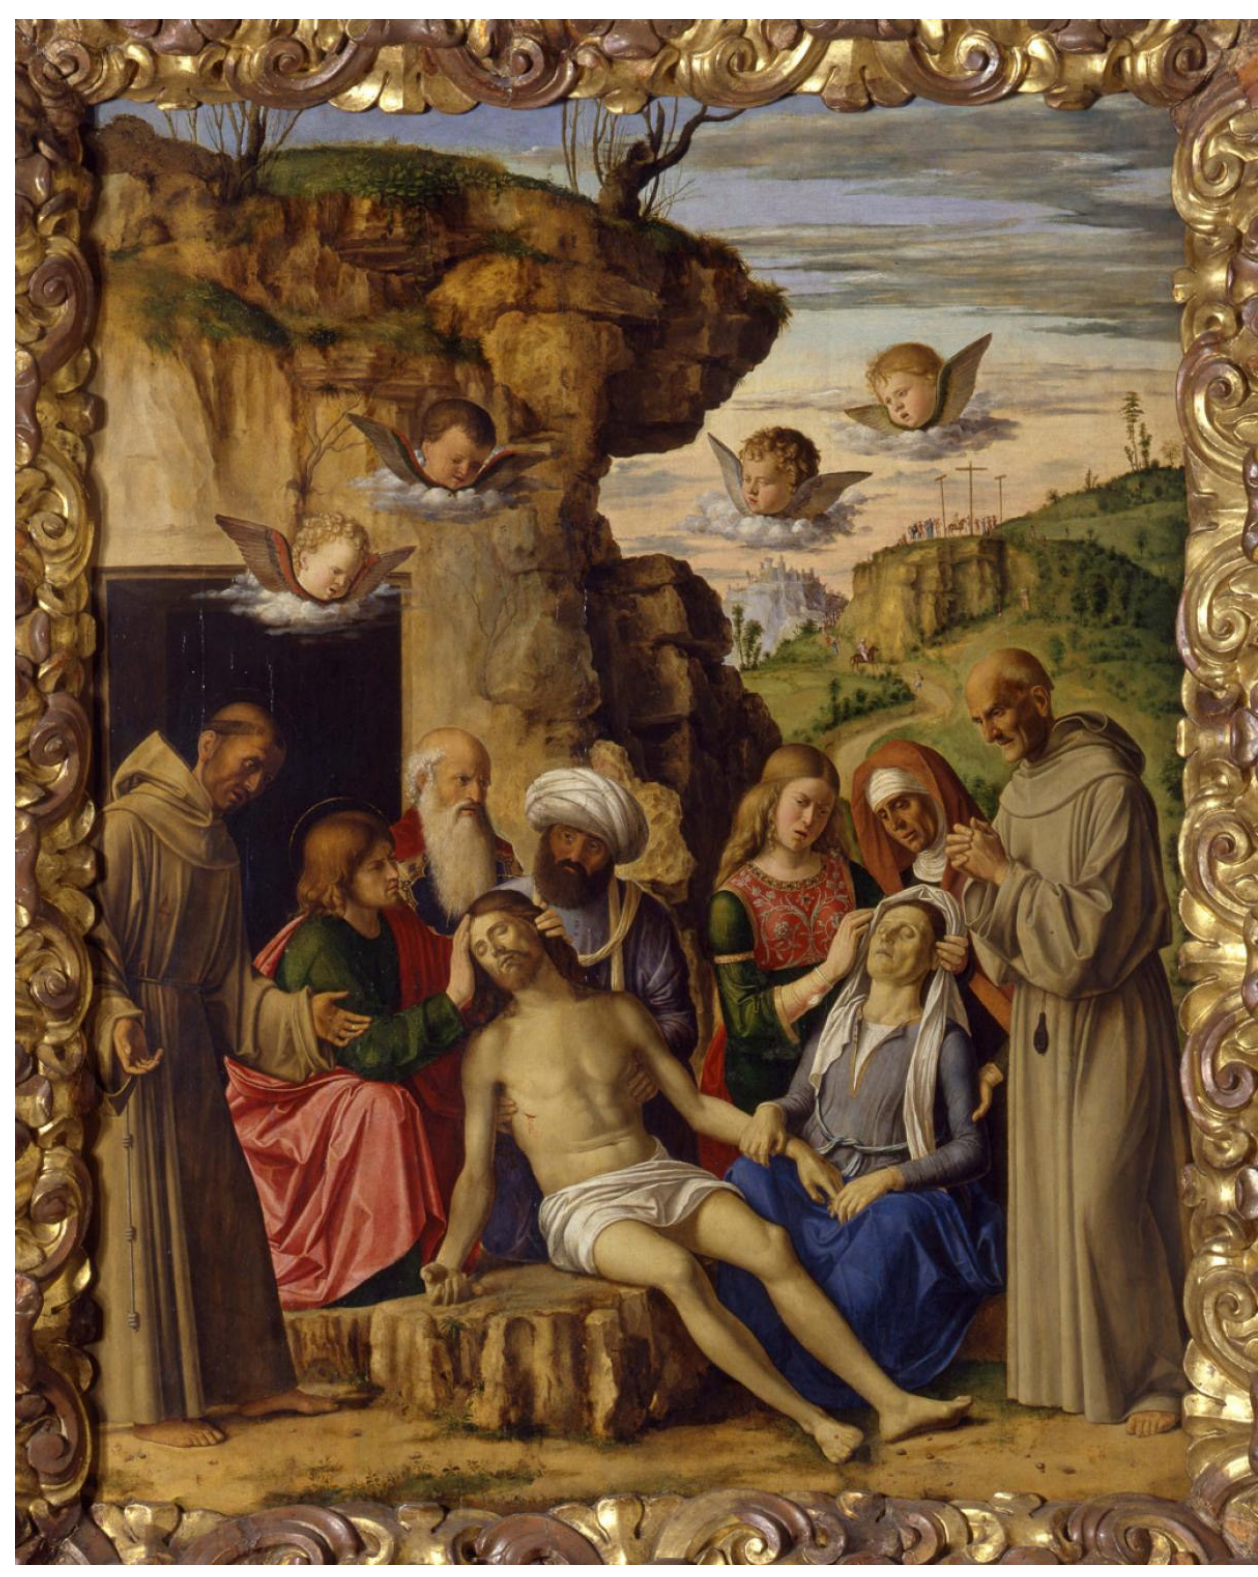
Figure 4. Cima da Conegliano, Lamentation over the Dead Christ with Sts. Francis and Bernardino , 1495. Panel. Galleria Estense, Modena, Italy. Image Courtesy of Galleria Estense, Modena, Italy; https://www.gallerie-estensi.beniculturali.it (accessed on 20 June 2021).